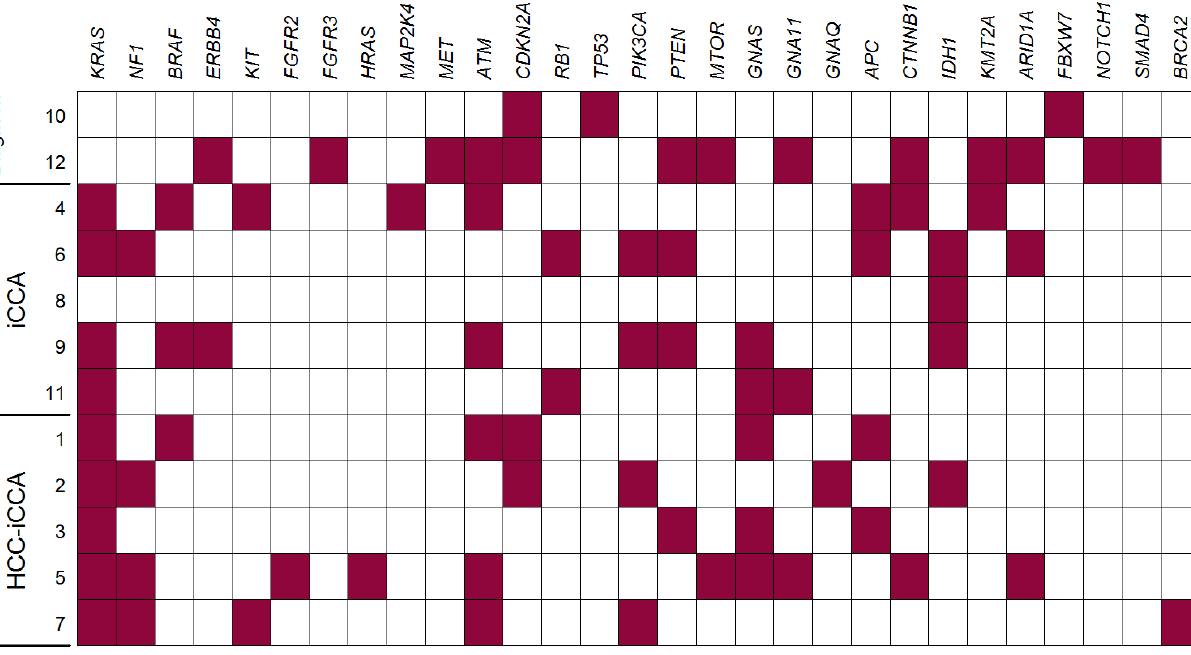
Figure 1. Genes presenting mutations in each of 12 patients affected by iCCA/HCC-iCCA who underwent liver transplan- tation (red box indicates the presence of mutation; white box indicates the absence of mutation).